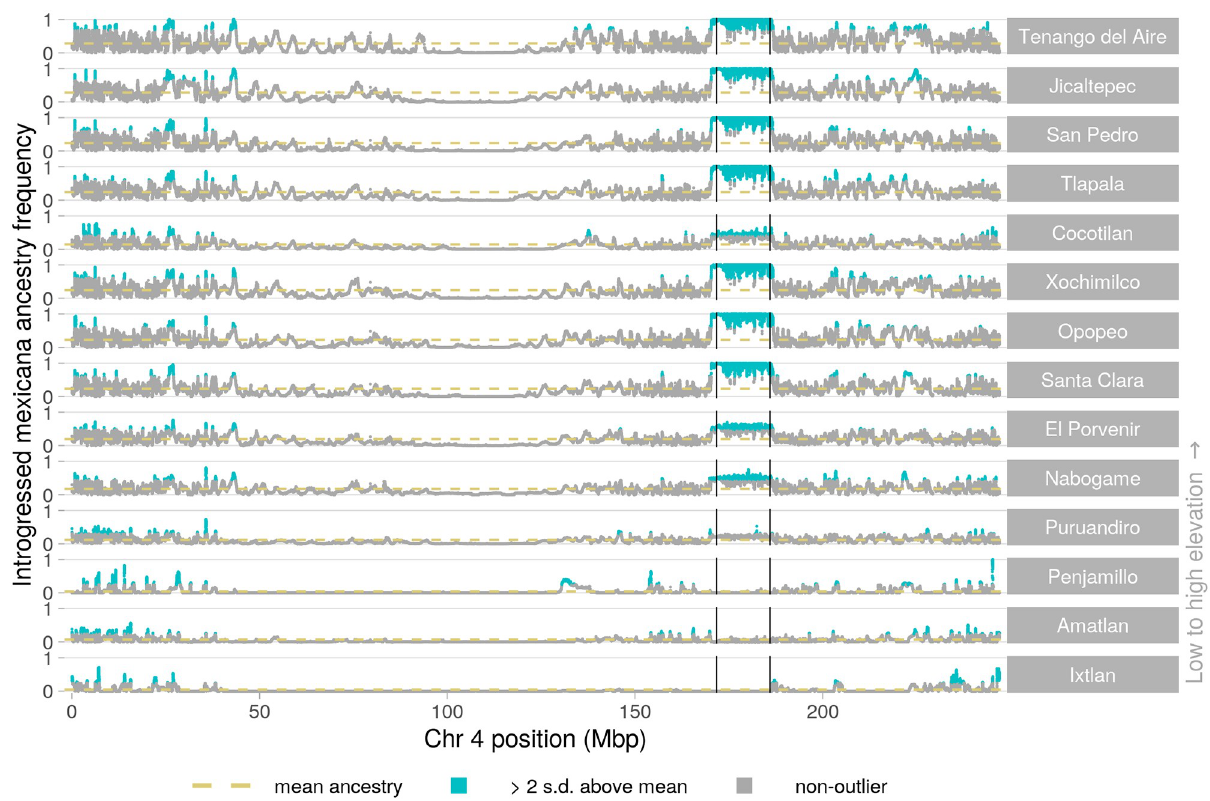
Fig 5. Introgression in maize populations across chromosome 4. Local introgressed mexicana ancestry frequency for each maize population compared to their genomewide mean. Populations are ordered from high to low elevation (top to bottom). High introgression peaks with more than 2 standard deviations above the population mean introgressed mexicana ancestry are highlighted in blue. Vertical black lines show the previously identified endpoints for a large inversion ( Inv4m ; coordinates from Fig 3 of [50]). For local ancestry on other chromosomes and for maize introgression into sympatric mexicana , see S11–S29